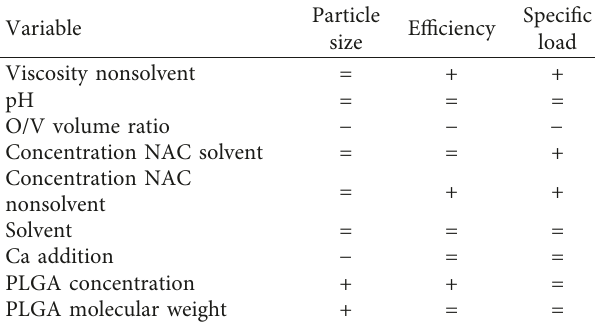
Table 2: Effect of variables on particle size, entrapment efficiency, and specific